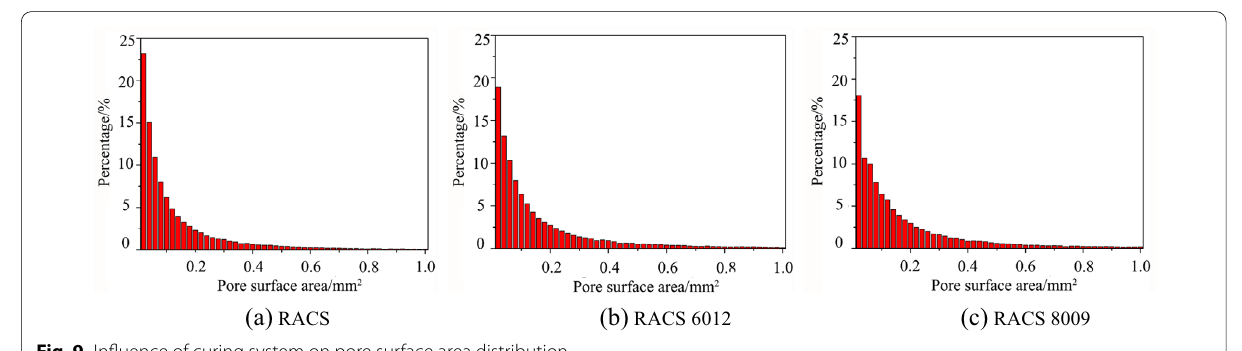
Fig. 9 Influence of curing system on pore surface area